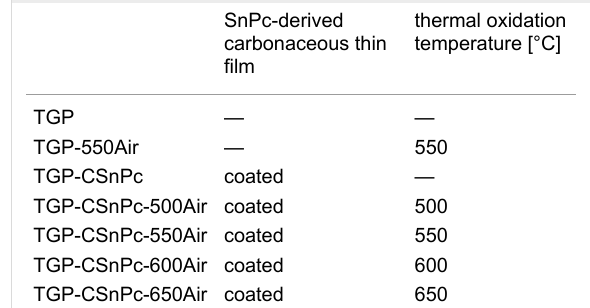
Table 1: Conditions for TGP surface treatments and obtained sam-